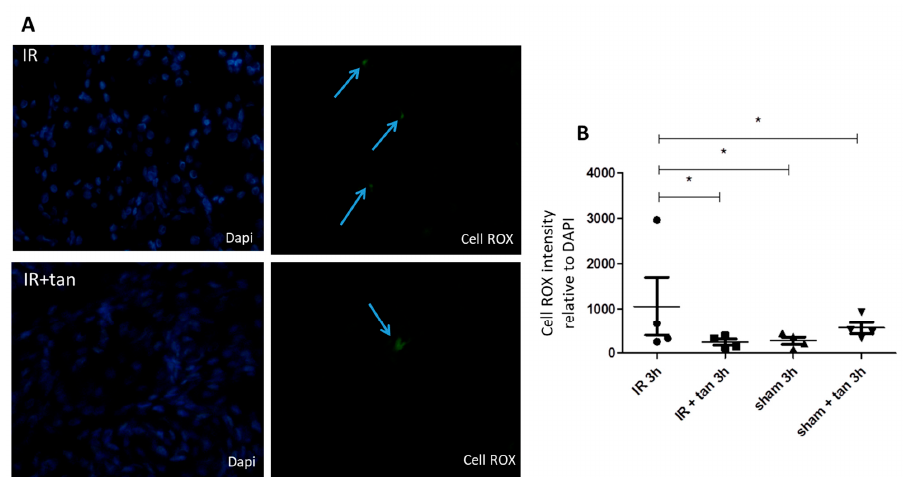
Figure 6. Tannic acid prevents oxidative stress in ischemia–reperfusion kidneys. Reactive oxygen species production induced by ischemia–reperfusion injury was evaluated by cell ROX staining. ( A ) Representative pictures (40X) of staining in kidney biopsies after 3 h of reperfusion following warm ischemia with or without tannic acid injection; ( B ) quantitative evaluation of staining. n = 4, values are mean ± SD, * p < 0,05.